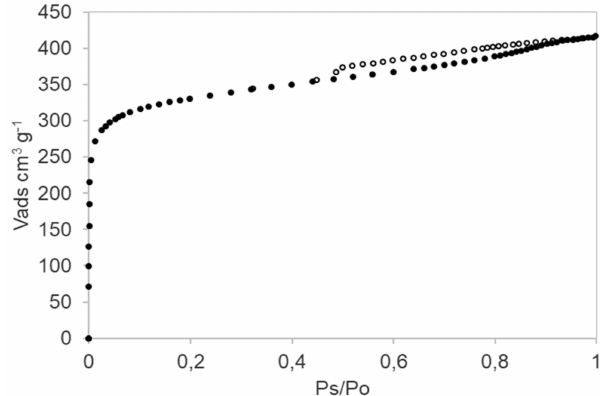
Figure 4. ACF’f N 2 adsorption-desorption isotherms, (solid symbols: adsorption; open symbols: desorption).